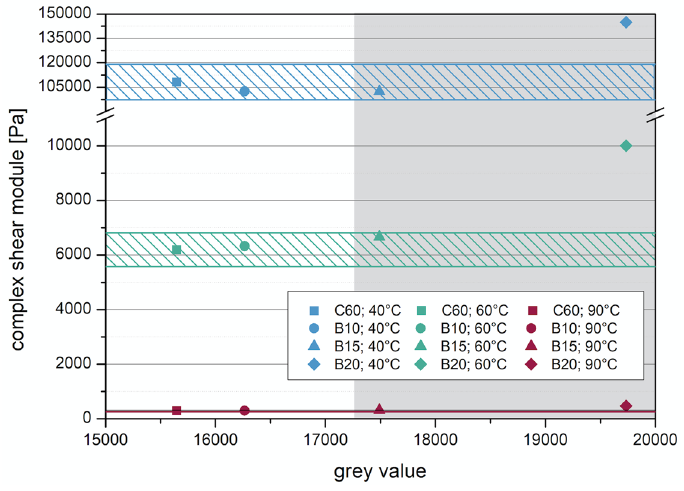
Figure 18. Correlation between complex shear module and gray value—barite powder.